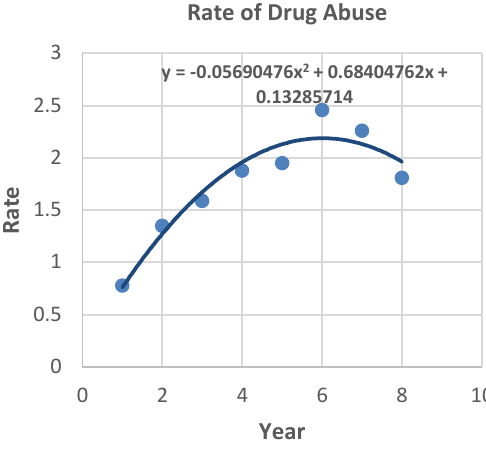
Figure 1. Nonlinear Quadratic Trend Line for Rate of Drug Abuse in Kano